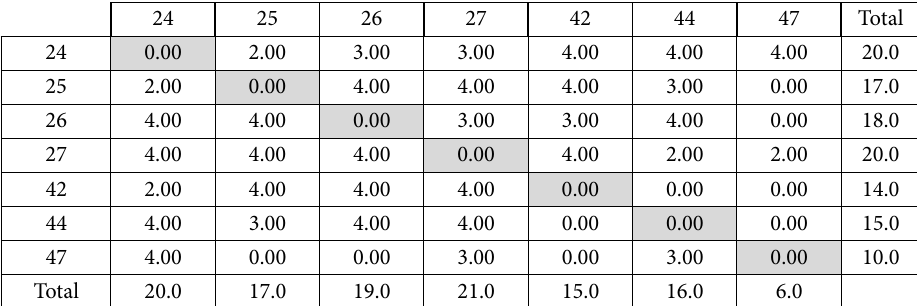
Table 4. Direct influence matrix for C2 Management / Human Resources